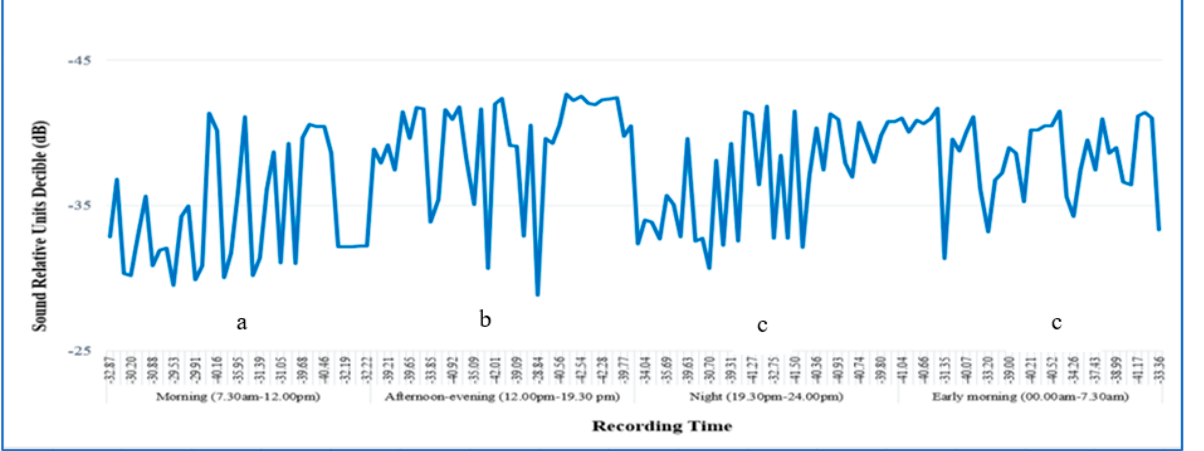
Figure 7. The relative spectral amplitudes (dB) of the red palm weevil larval sound signal were